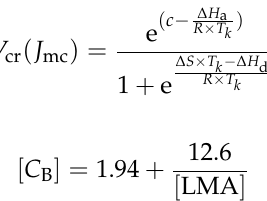
Betula alnoides , and Castanopsis hystrix grown under three different irradiance treatments. Figure grown under three different irradiance treatments. Table S1: Mesophyll conductance ( g m ), and CO 2 concentration at carboxylation site ( C c ) calculated by three methods in four species seedling leaves under different irradiance treatments. Table S2: Quantity of leaf N per area allocated to